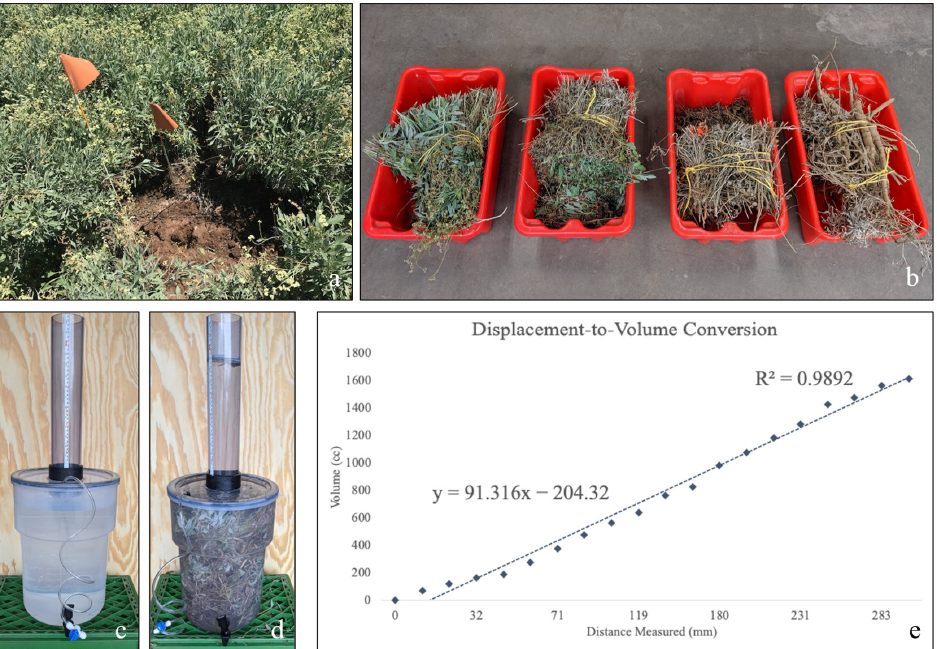
Figure 4. Harvesting one square meter of guayule ( a ); quartering the sample along its vertical axis ( b ); water is strategically removed and set aside to allow for the addition of plant material ( c ). Once added, the removed water is replaced and the displacement recorded ( d ); equation used to convert linear displacement to volumetric units ( e ).